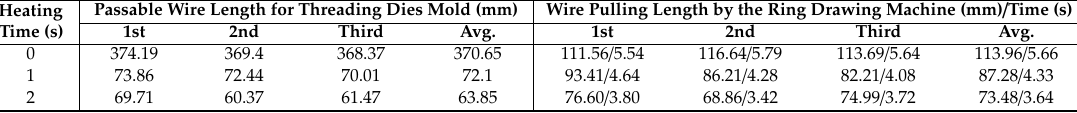
Table 11. Results based on wire pulling speed: k11(20.15 mm / s).